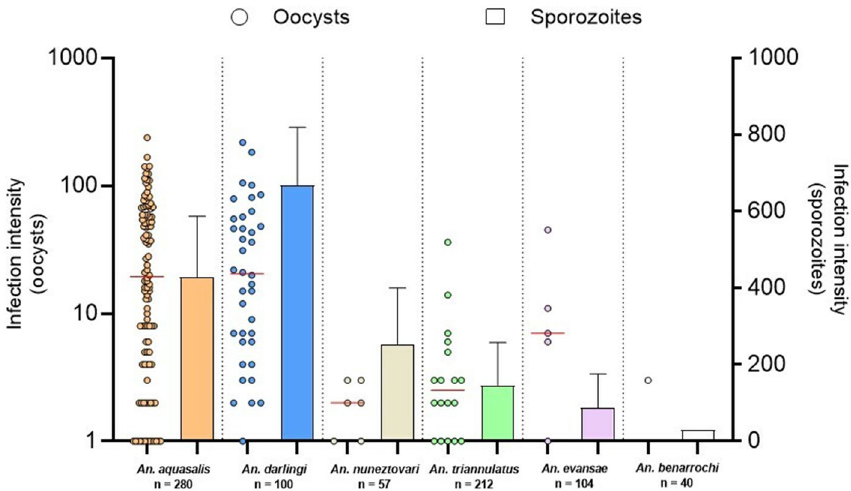
Figure 4. Comparison between the number of sporozoites and oocysts in six species of Anopheles infected with P. vivax . Plotted with GraphPad Prism v.6.00 software (San Diego, CA, USA, https:// www. graph pad. com/).